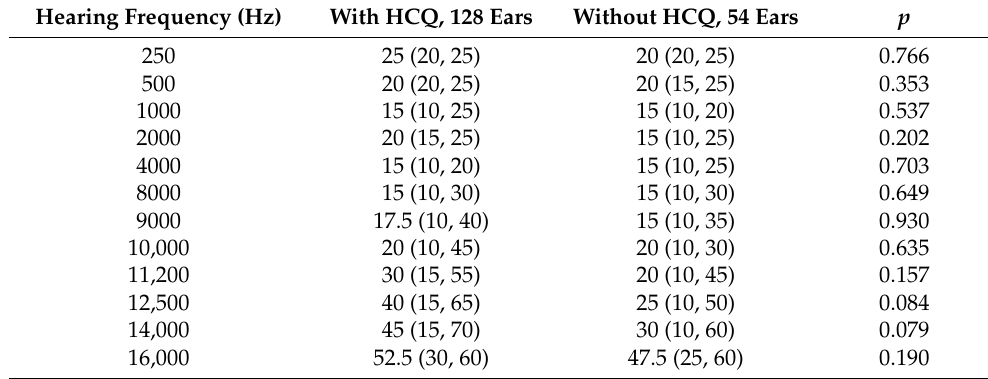
Table 3. Hearing threshold at each frequency in SLE patients using and not using